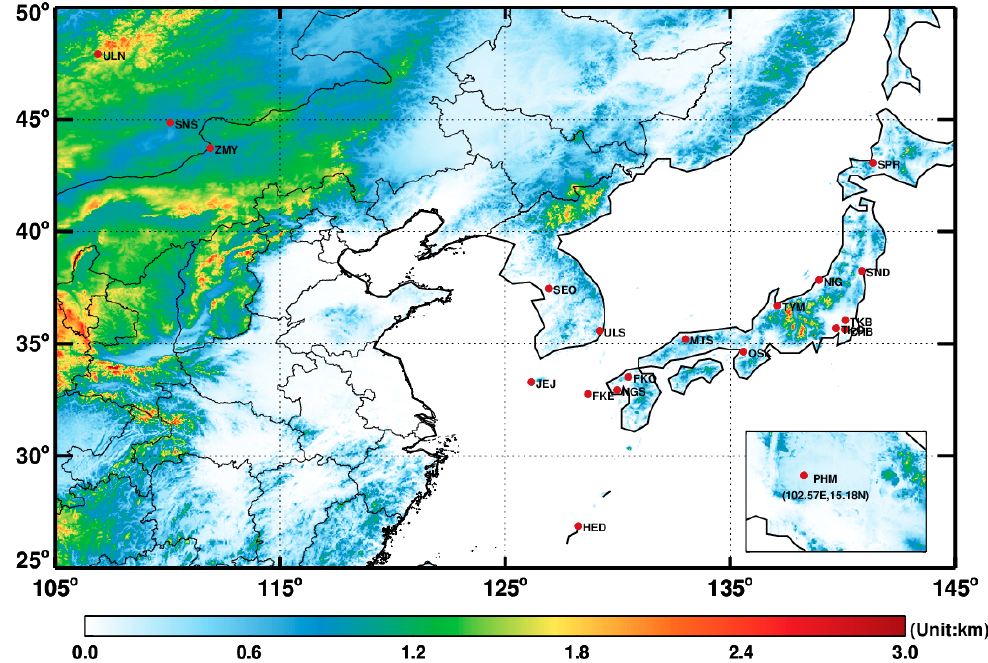
Figure 1. The location of AD-Net lidar stations (the red solid circle). The color represents surface elevation.